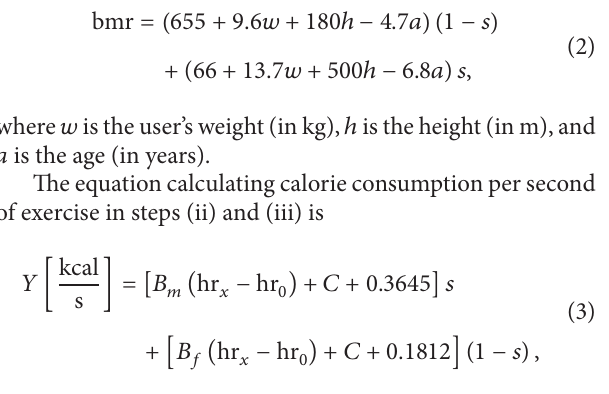
Figure 7: Calorie consumption calculation